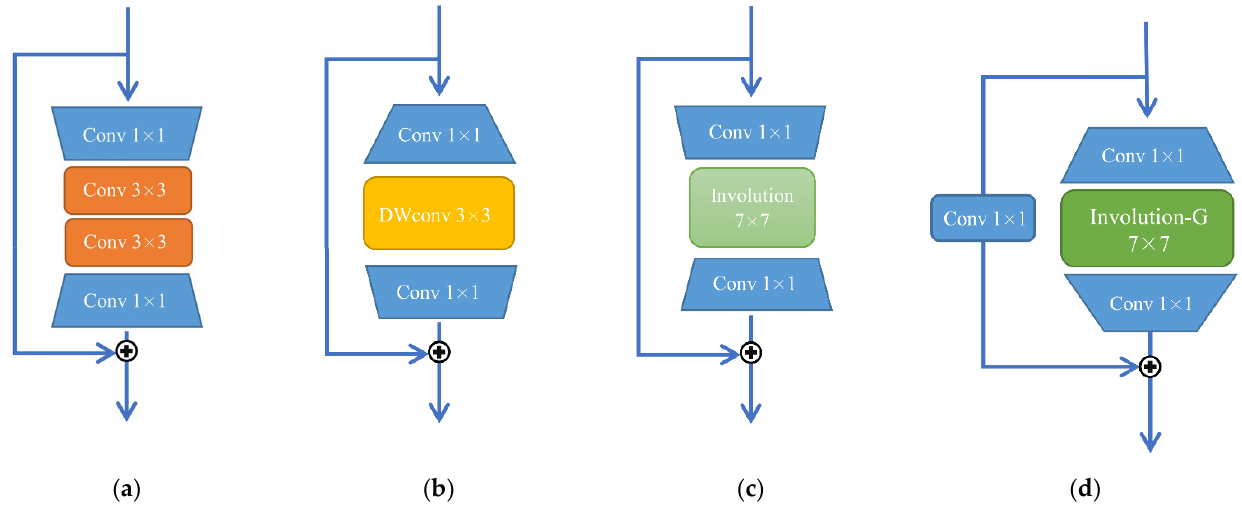
Figure 3. Bottlenecks in ( a ) ResNet; ( b ) Mobilenet-v3; ( c ) Rednet-50 [41]; and ( d ) RIIAnet .